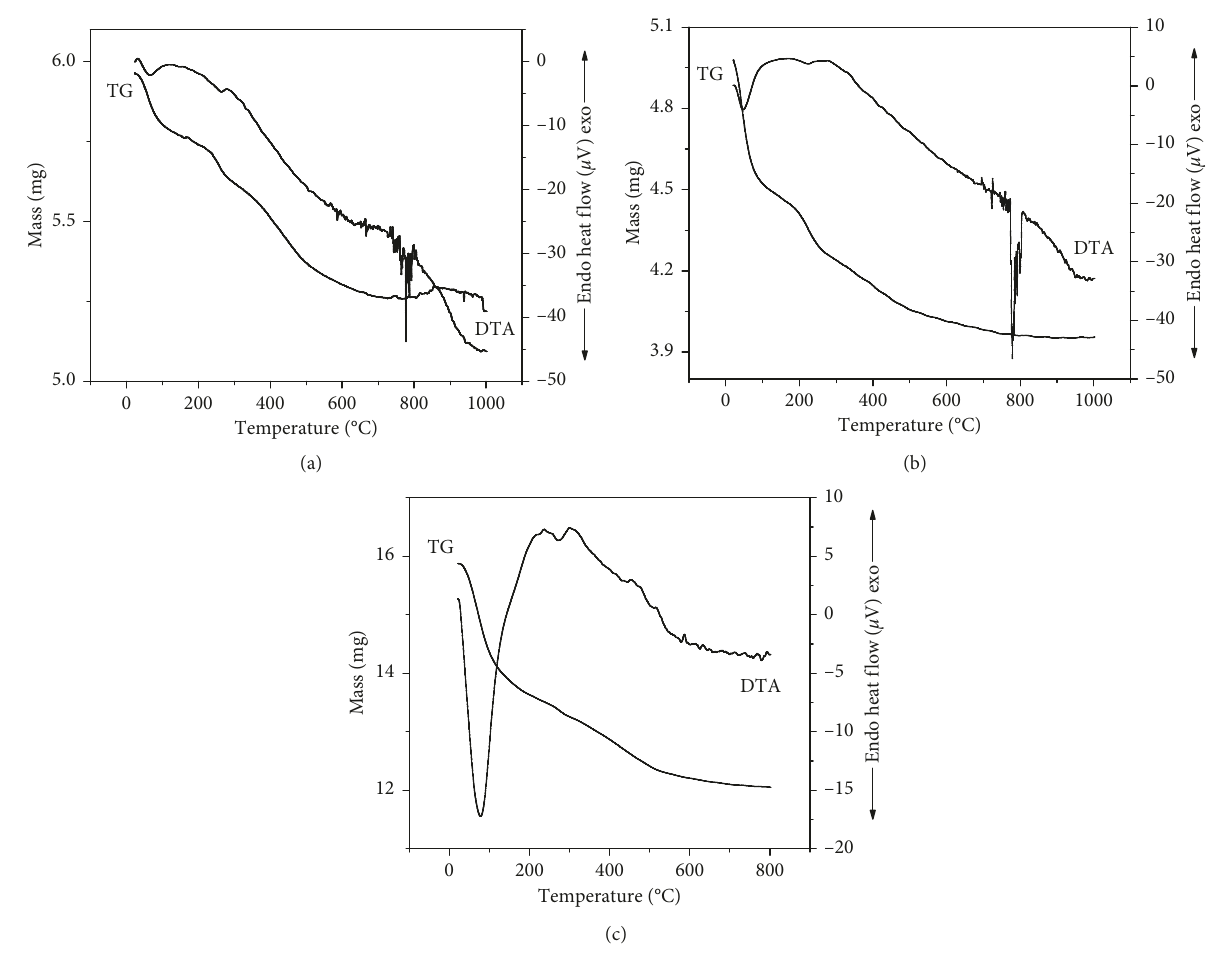
Figure 3: TG and DTA curves of B (a), Fe-B (b), and Al-B (c).